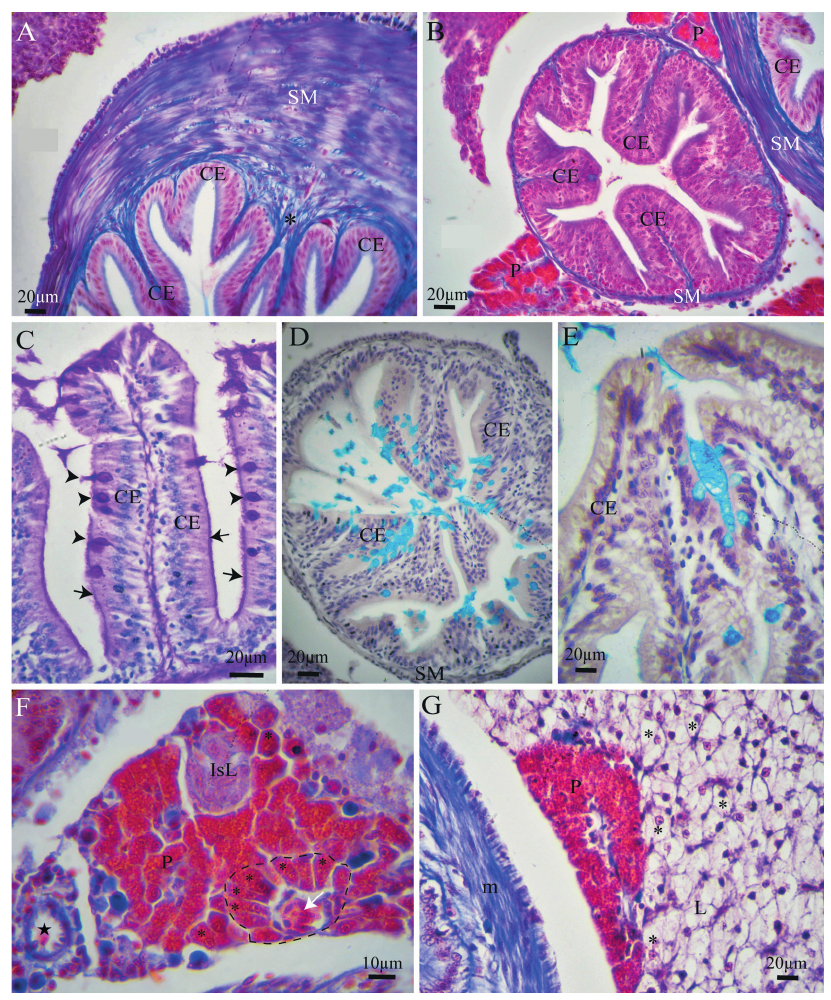
FIGURE 3 | Histological sections of the digestive tract of Paracheirodon axelrodi, stained with Masson Trichrome (MT) ( A , B , F , G ), Periodic Acid- Schiff (PAS) ( C ) and Alcian Blue (AB) ( D , E ). A. Cross section of the pyloric portion of the stomach, showing the CE mucosa and a layer of loose connective tissue (asterisk) under the epithelium. Note the absence of GG and a great development of the inner circular layer of SM. B. Cross section of a pyloric cecum, showing mucosal CE cells arranged in a brush border fashion and with numerous folds, and a thin layer of SM. Part of the pyloric stomach can be seen in the upper right corner. A portion of the pancreas (P) can be seen in the upper and lower corners. C. Cross section of intestine showing the PAS positive goblet cells (GCs) (arrowheads) with cytoplasm filled with glycoconjugates. The PAS reaction for neutral glycoconjugates produces an intense purple stain in the mucous granules of GCs and emphasizes the brush border of the enterocytes (arrow). D-E. Pyloric cecum (D) and intestine (E) showing AB positive GCs, with a similar distribution pattern in the epithelium. Thanks to the AB technique for acid mucosubstances, GCs show a strong positive blue staining. F. Pancreas section. The exocrine pancreas is formed by acini (segmented line), which are made up of a group of pyramidal-shaped secretory cells, called acinar cells. Towards the central part of the acinus, a small afferent vein is observed (white arrow). A prominent feature of acinar cells is the presence in their apical regions of aggregated bright eosinophilic zymogen granules (asterisk) that face the narrow lumen. The endocrine pancreas is formed by the Islets of Langerhans (IsL) composed of small cells with a pale-stained granular cytoplasm, in contrast to the larger acinar cells of the exocrine gland, which stain more strongly. On the left is a pancreatic duct (black star) with simple cuboidal epithelium. G. Liver (L) and pancreas (P) section. Many fish livers contain diffuse exocrine pancreatic tissue and are therefore called hepatopancreas. The liver showed polyhedral hepatocytes (asteriks) with a granular and poorly stained cytoplasm, the nuclei are spherical and centrally located presenting well delineated nucleoli. On the left is the smooth muscle layer (SM) of a portion of the intestine. CE, simple columnar epithelium; GCs, goblet cells; GG, gastric glands; SM, smooth